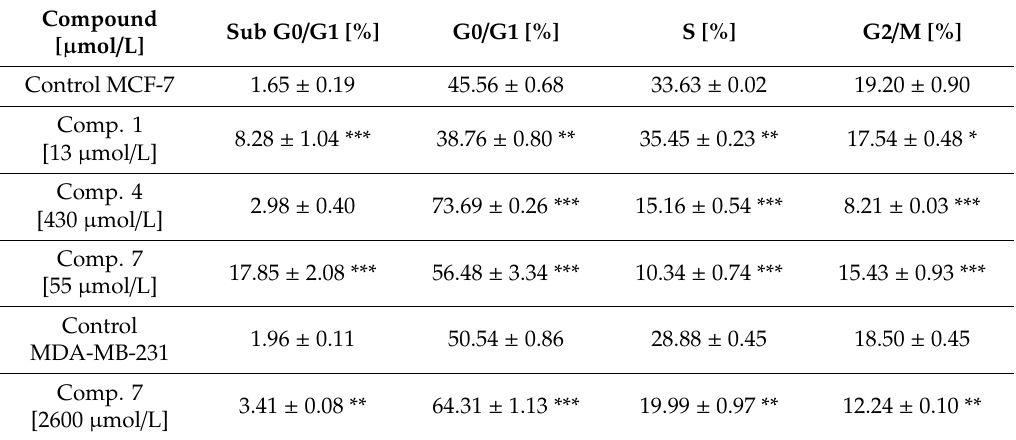
Table 5. The e ff ects of selected sulfonamides on cell cycle progression in MCF-7 and MDA-MB-231